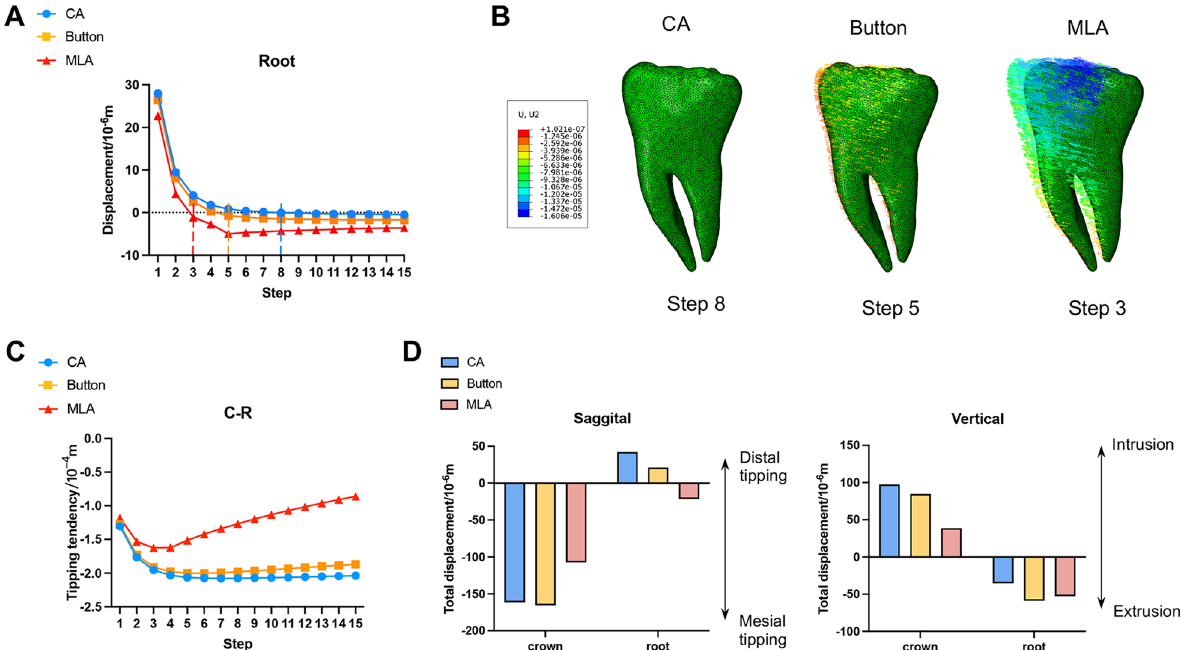
Fig. 9 The long-term tooth movements. A The root movement at each iteration in the sagittal direction. B Tooth movement patterns in CA, button, and MLA groups at the 8th, 5th, and 3rd steps, respectively. C The curve of tipping tendency. D Cumulative displacement of crown and root in the sagittal and vertical